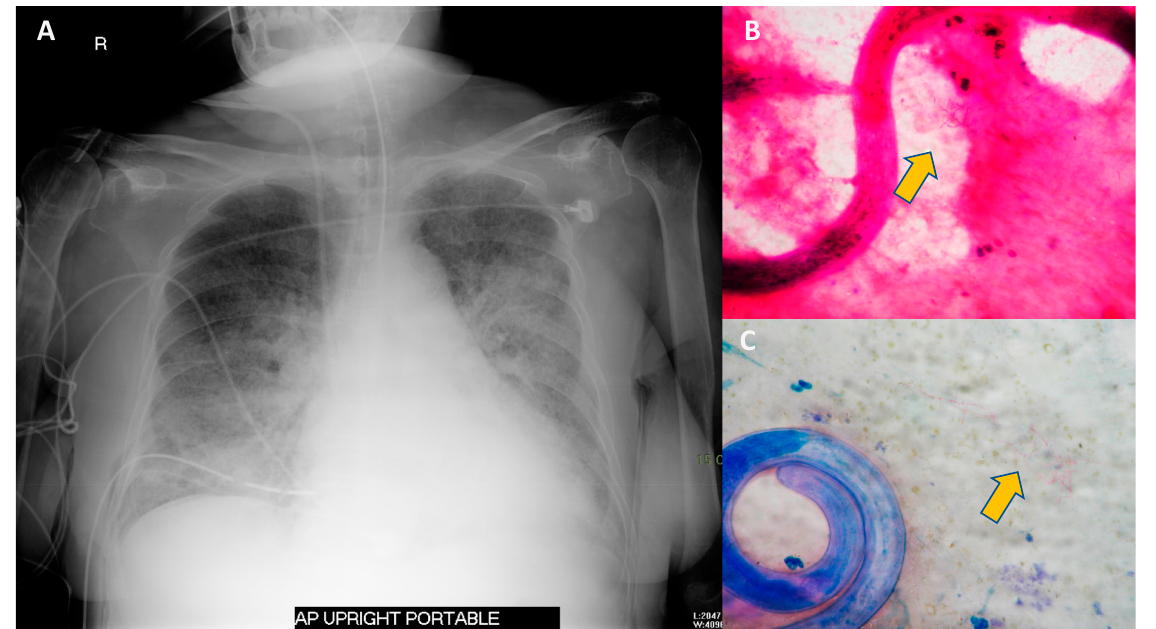
Figure 4. Chest radiography and sputum examination from a case of S. stercoralis hyperinfection syndrome in an immunocompromised patient. A 75-year-old Thai woman with temporal arteritis had been treated with prednisolone 20 mg/day for 4 months. She developed fever and diarrhea for 2 days prior to respiratory failure. The chest radiography revealed bilateral patchy infiltration ( A ). Sputum examination with Gram staining ( B ) and Modified Acid-Fast staining ( C ) revealed filariform larvae of S. stercoralis and a positive branching filamentous organism (arrow), indicating Nocardia species. Blood cultures grew Escherichia coli . She was diagnosed with S. stercoralis hyperinfection syndrome with concurrent Gram-negative bacteremia and pulmonary nocardiasis. She was treated with broad-spectrum cephalosporin, cotrimoxazole and ivermectin.